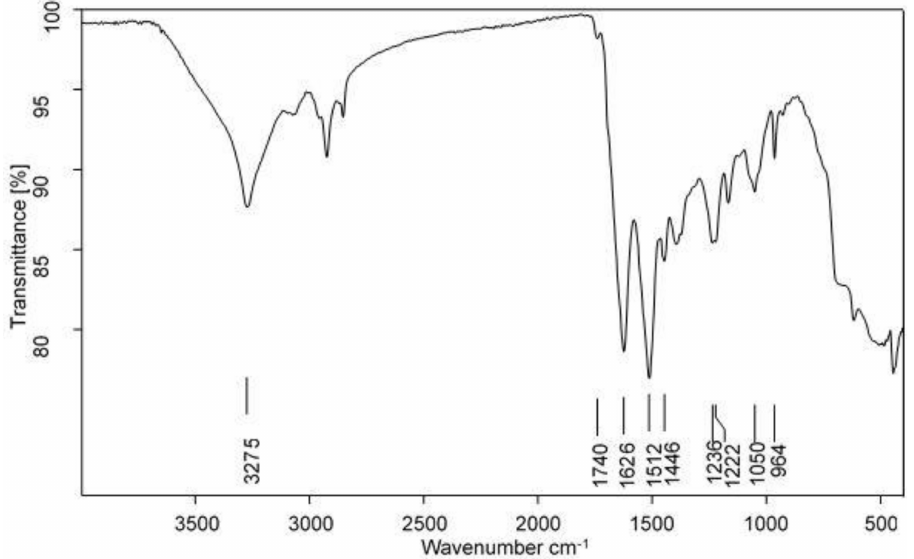
Figure 14. FTIR of degummed